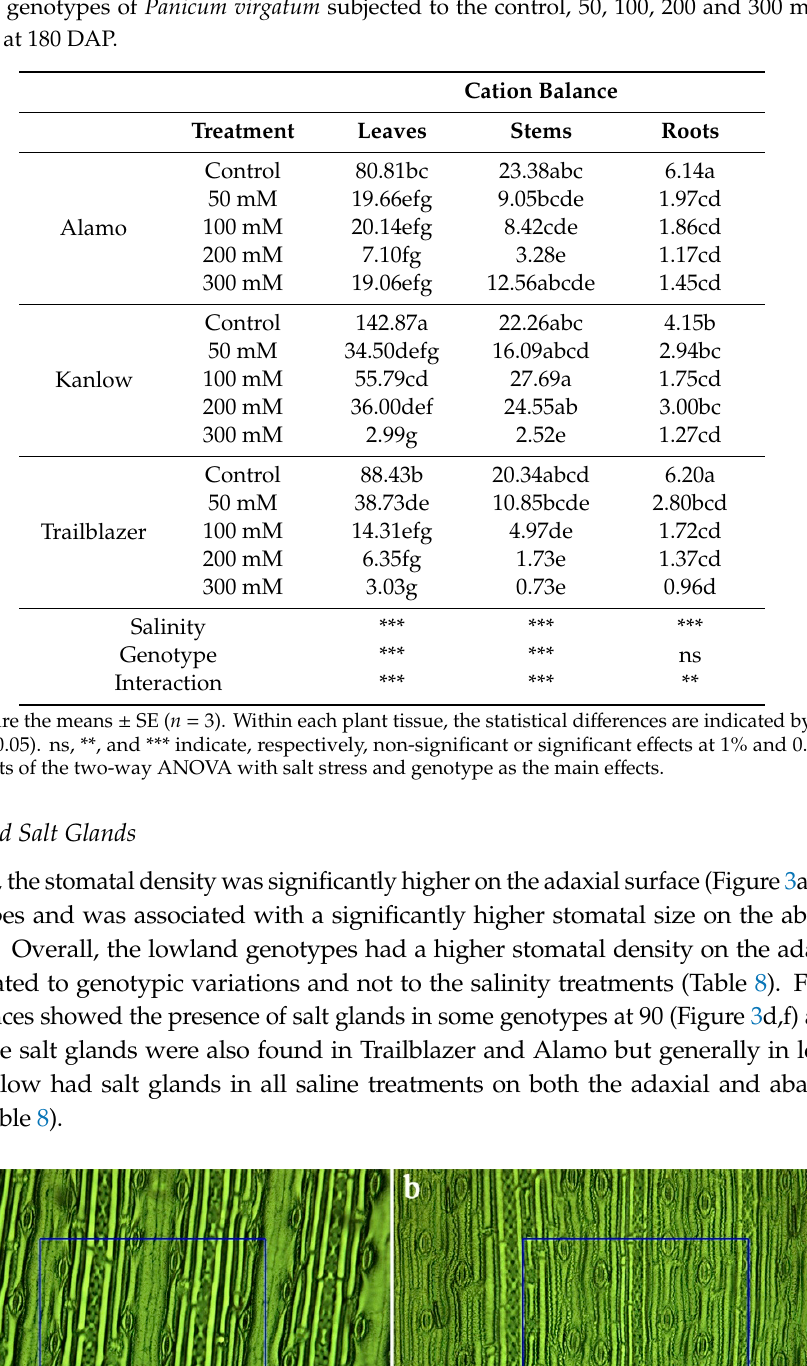
Figure 3. Stomatal impressions for the Kanlow genotype of Panicum virgatum at DAP 90 from the ( a , c , e ) adaxial and ( b , d , f ) abaxial surfaces. The images show different treatments—( a , b ) control, ( c , d ) 50 mM and ( e , f ) 100 mM of NaCl. The data within the blue squares represent an area of 0.09 mm 2 .